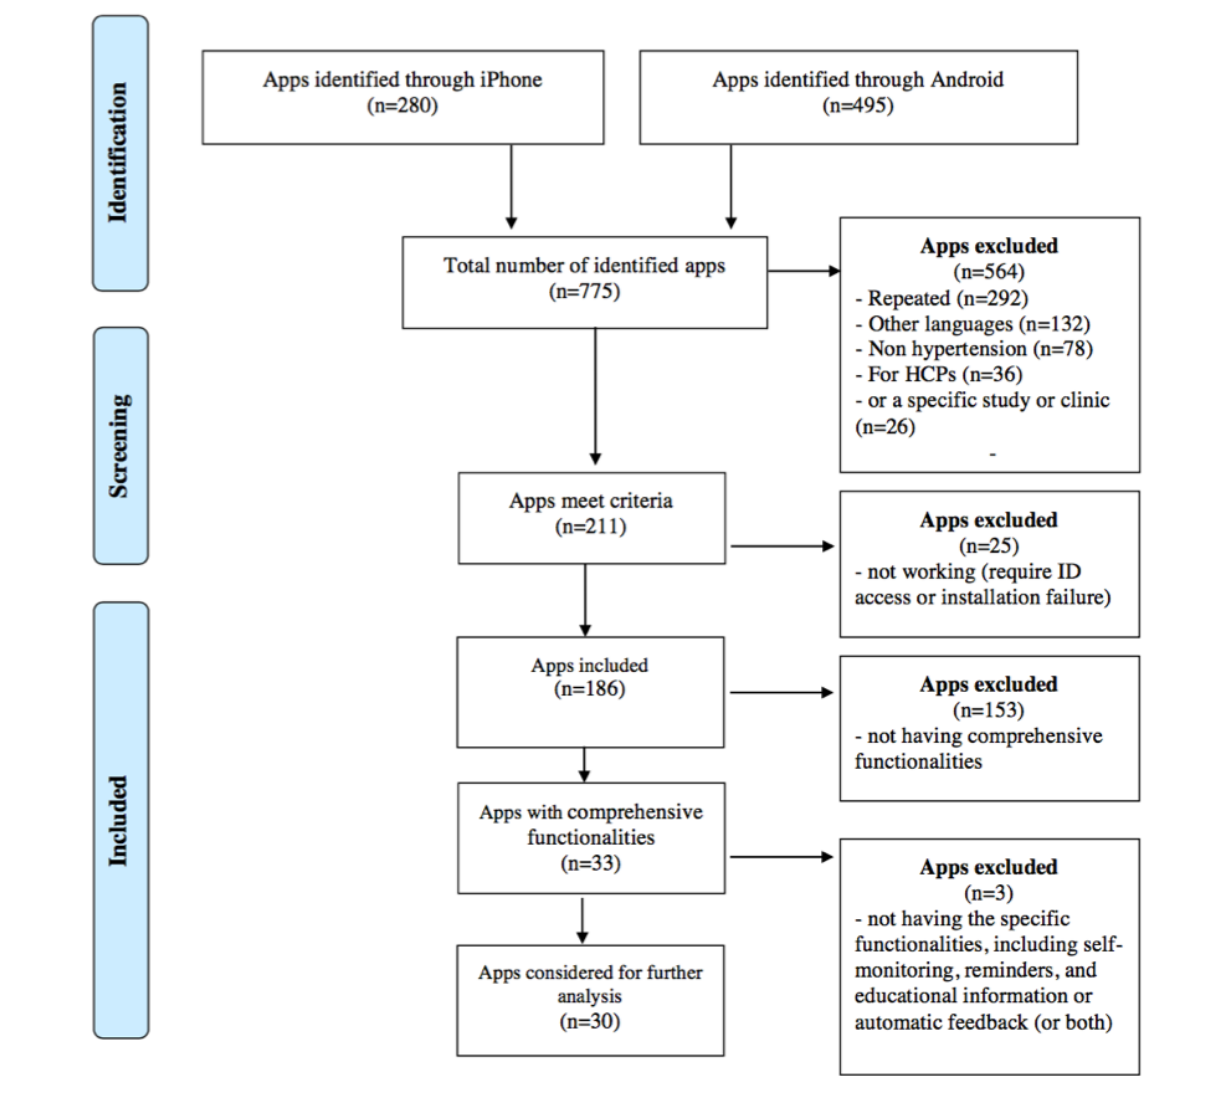
Figure 1. Flow diagram of the app-search process. ID: identification; HCP: health care provider.